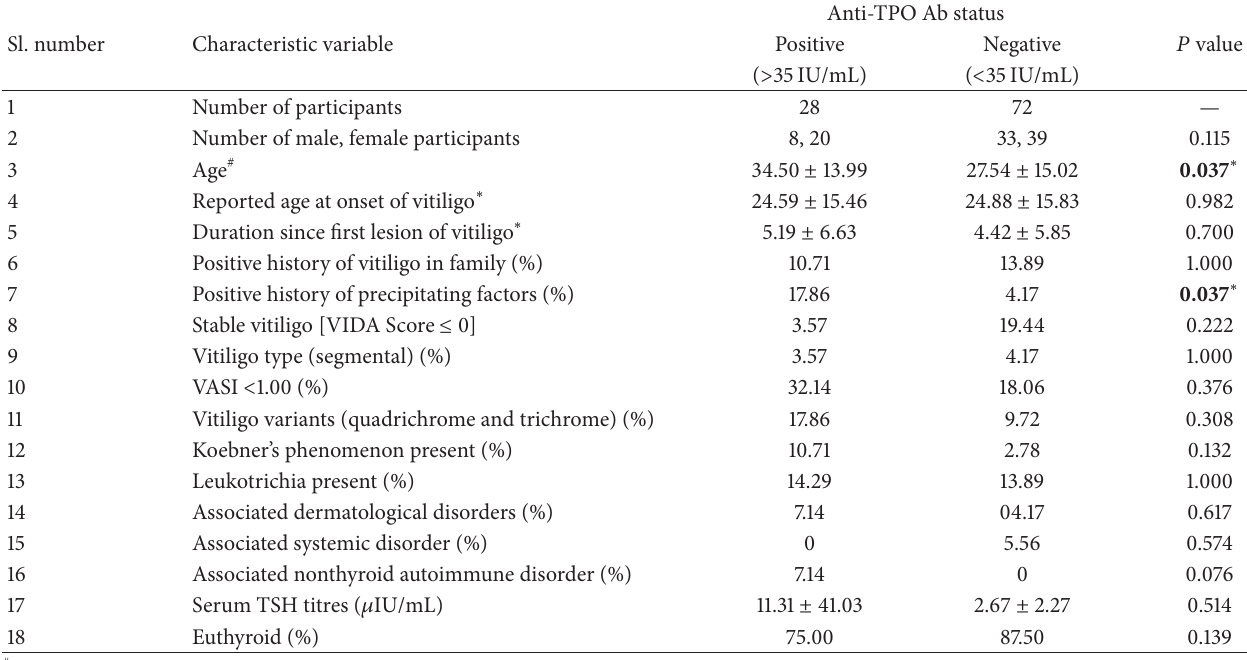
Table 2: Sample characteristics of study participants according to anti-TPO Ab